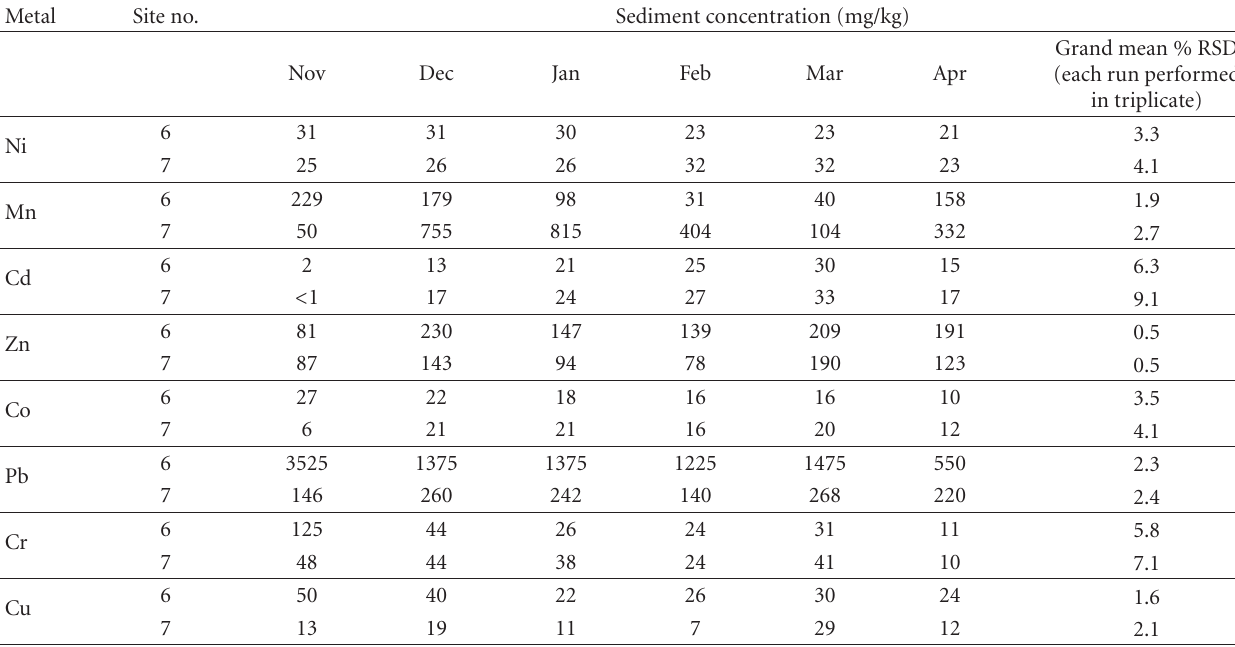
) over a six-month period, 2004-2005. dw